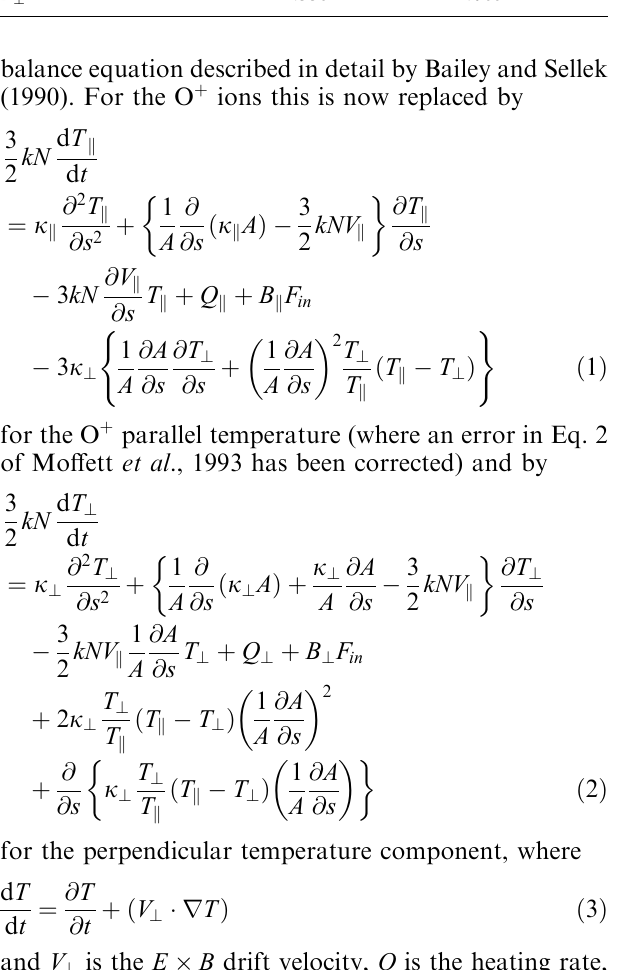
Table 2. Values of the ion frictional heating partition coe(cid:129)cients for the atmospheric composition shown (following Winkler et al ., 1992) Ion composition Neutral